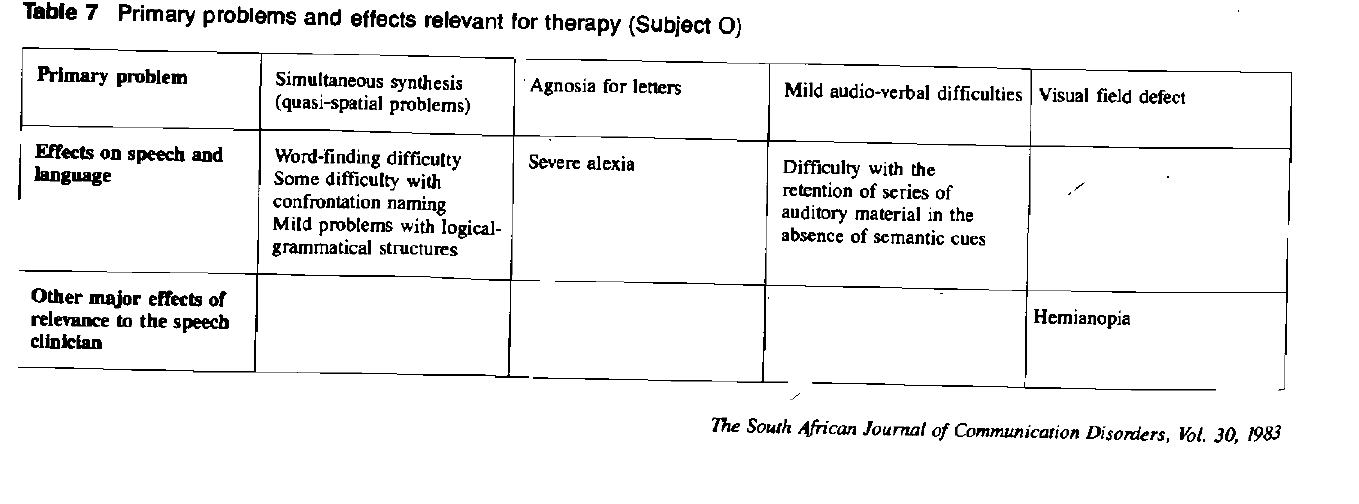
Table 7 Primary problems and effects relevant for therapy (Subject O) Primary